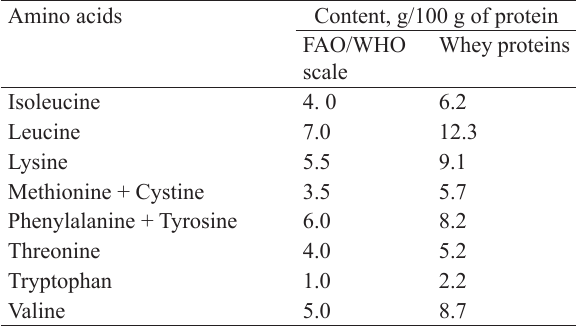
Table 4 Content of essential amino acids Amino acids Content, g/100 g of